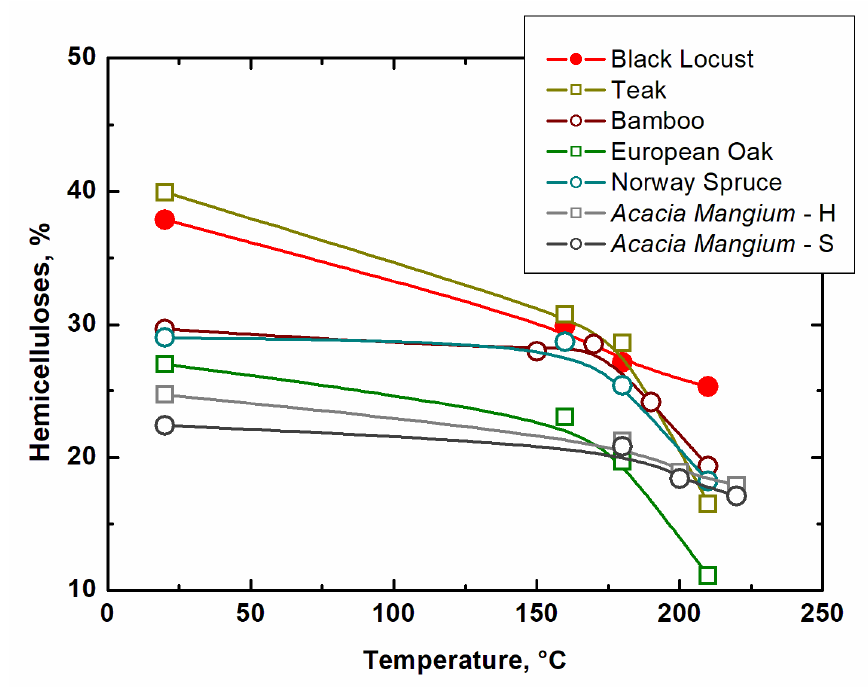
Figure 6. Influence of thermal modification on hemicelluloses (teak [23], bamboo [19], European oak, Norway spruce [20], Acacia mangium —heartwood, sapwood [21]).